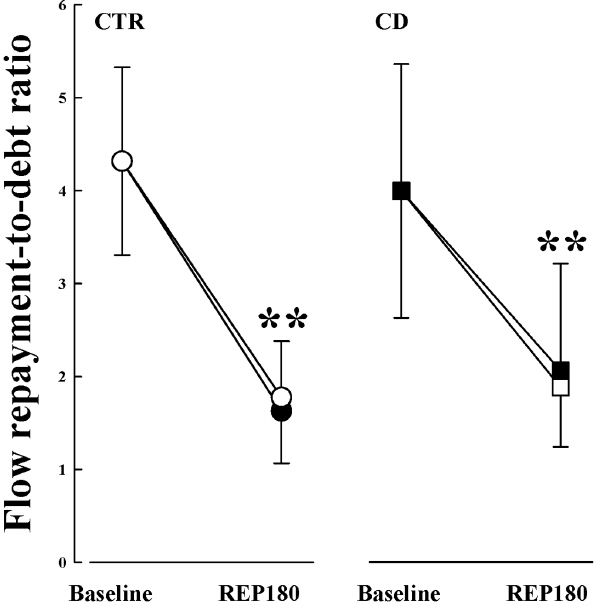
blood flow (mL/min); Q peak : peak blood flow (mL/min) after 20-sec LAD occlusion; CVC base , CVC peak : coronary vascular conductance at baseline and at peak flow during RH responses.